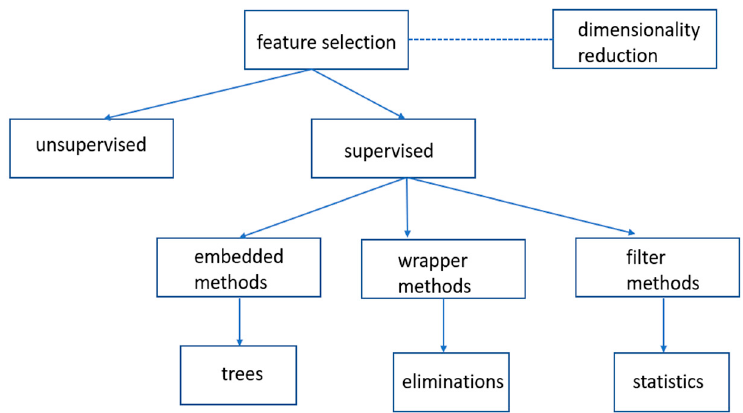
Figure 2. Feature selection techniques.